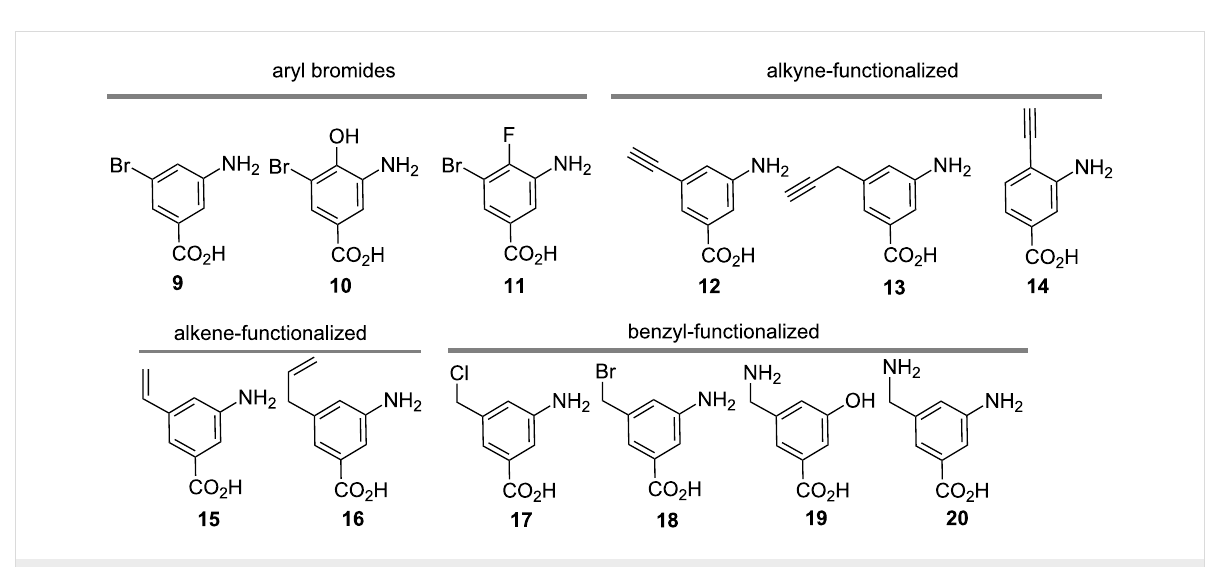
Figure 1: m- Aminobenzoic acid derivatives 9 – 20 tested as mutasynthons.